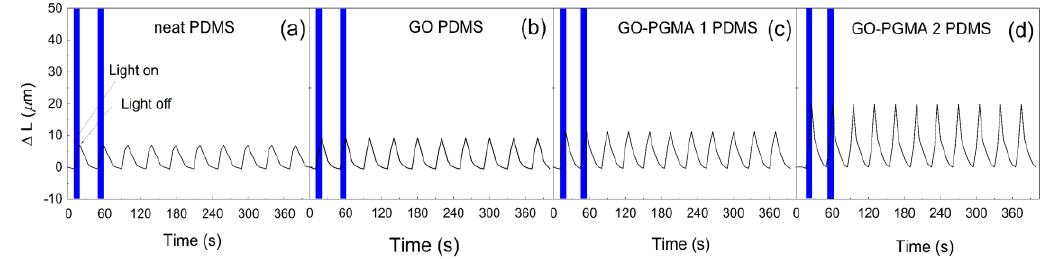
Figure 10. Photo-actuation performance of pure PDMS ( a ) and PDMS composites containing 0.1 vol.% of neat GO; ( b ) GO-PGMA-1; ( c ) and GO-PGMA-2 ( d ) at 6 mW irradiation intensity.